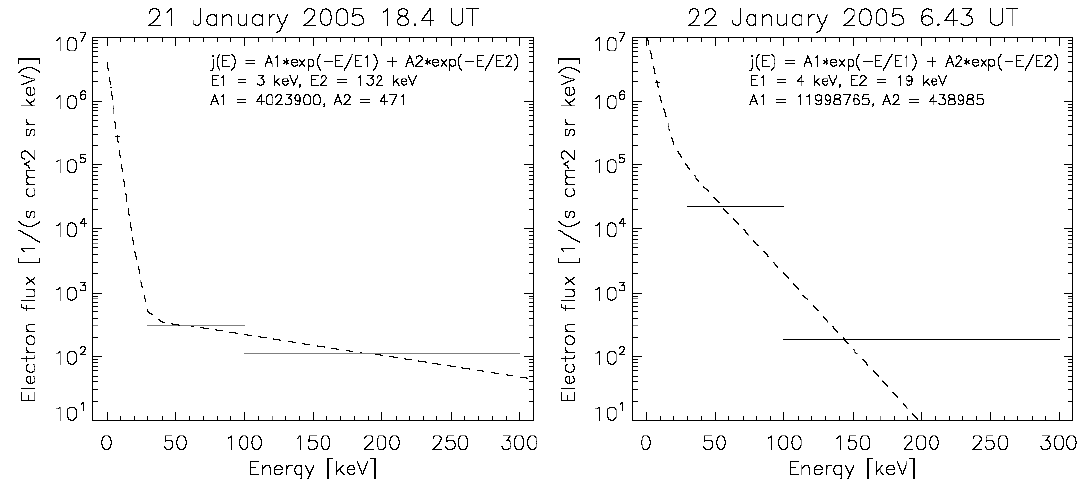
Fig. 6. The horizontal lines mark the electron flux in four channels 2.166–3.075keV, 6.503–9.467keV, 30–100keV, 100–300keV retrieved by interpolating measurement from the vertical TED and MEPED detectors on NOAA 15, 16, and 17 on 21–22 January 2005 at two selected times. The dashed line is the electron differential spectrum fitted to the flux in the four energy intervals.